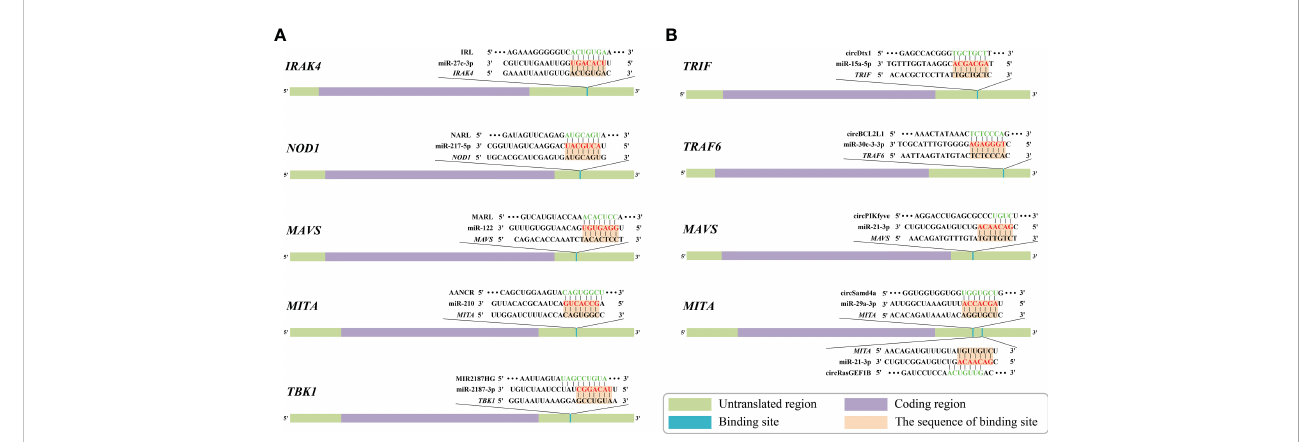
FIGURE 5 Predicted binding sites of identi fi ed competing endogenous RNAs (ceRNAs) associated with genes of nuclear factor-kappa B (NF- k B) pathways in aquatic animals. (A) Predicted binding sites of “ long non-coding RNA (lncRNA)-microRNA (miRNA)-mRNA ” ceRNA networks. (B) Predicted binding sites of “ circular RNA (circRNA)-miRNA-mRNA ” ceRNA networks. The red markings represent seed